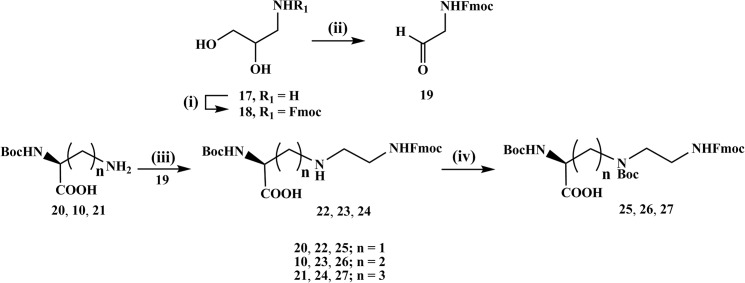
Synthesis of triamino acid building blocks with different distances between the α-amino group and the secondary amine.(i) Fmoc-OSu, MeOH/ pyridine, rt, 18 h (ii) NaIO4, THF, rt, 8 h (iii) NaBH3CN, 1% AcOH in methanol, rt, 18 h (iv) (Boc)2O, water:dioxane (v/v, 1:1), 10% aq. Na2CO3, rt, 18 h.